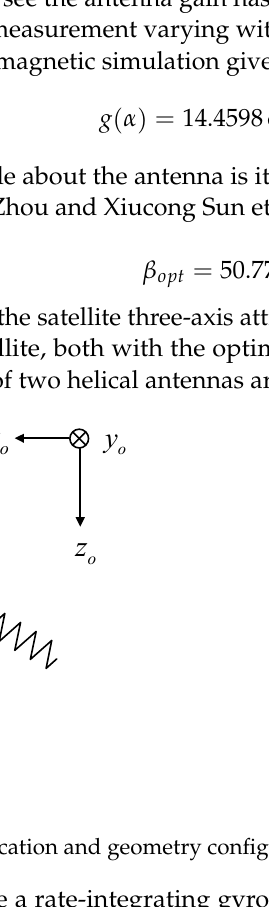
From the picture, we can see the antenna gain has a strong directivity along the boresight,